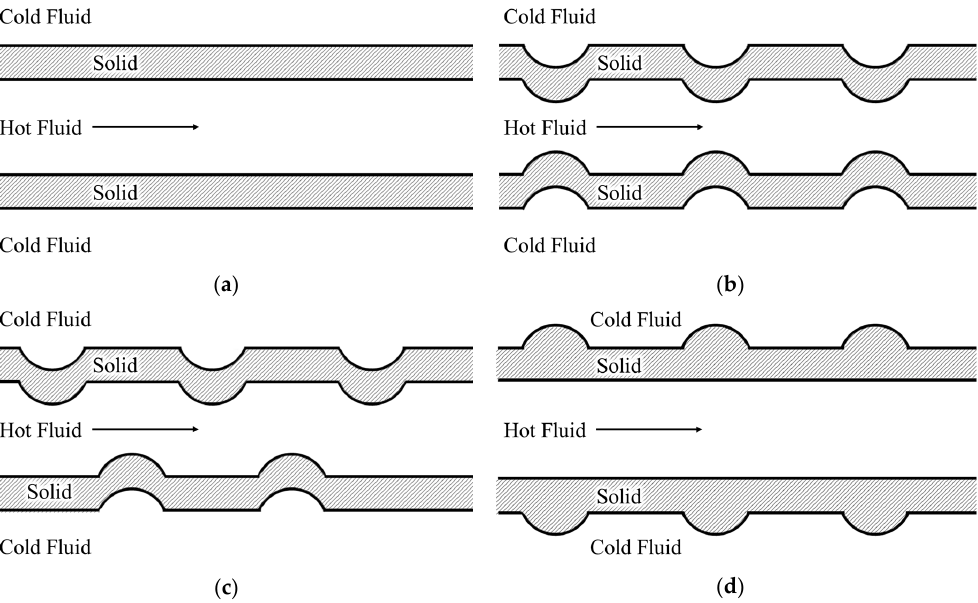
Figure 2. Schematic of the dimple arrangement: ( a ) flat; ( b ) inline; ( c ) staggered; and ( d ) bulged.